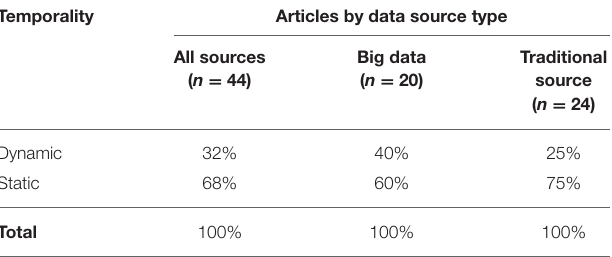
TABLE 2 | Distribution of articles by temporality of analysis and data source type.